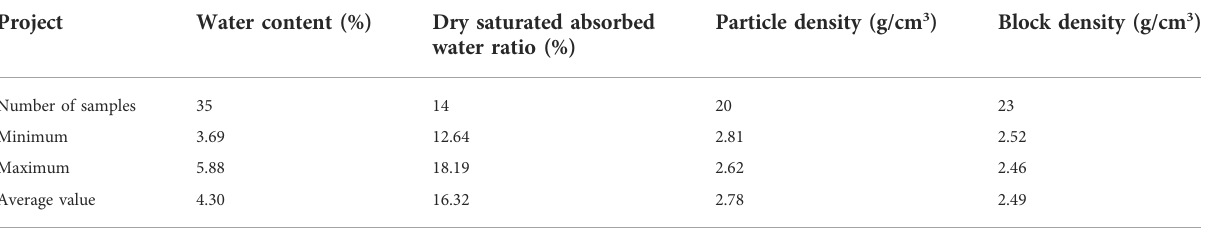
TABLE 1 Basic physical parameters.